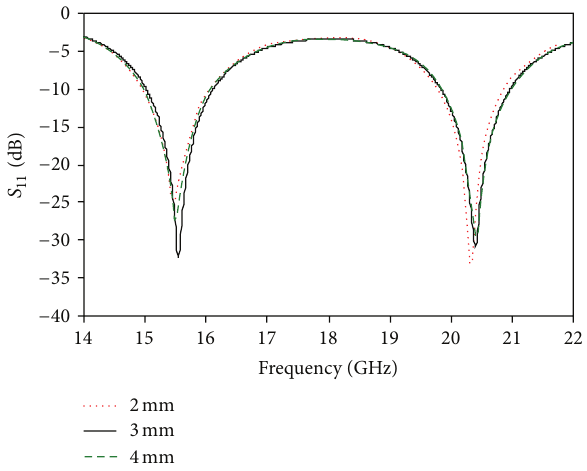
Figure 8: Simulated return loss for different values of 𝑊 3